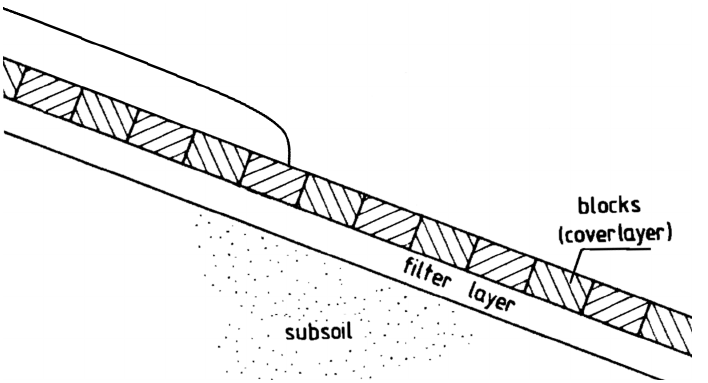
Figure 1. Overview of the layers on the landward slope of a block-covered dike, adapted from Bezuijen et al. [14].